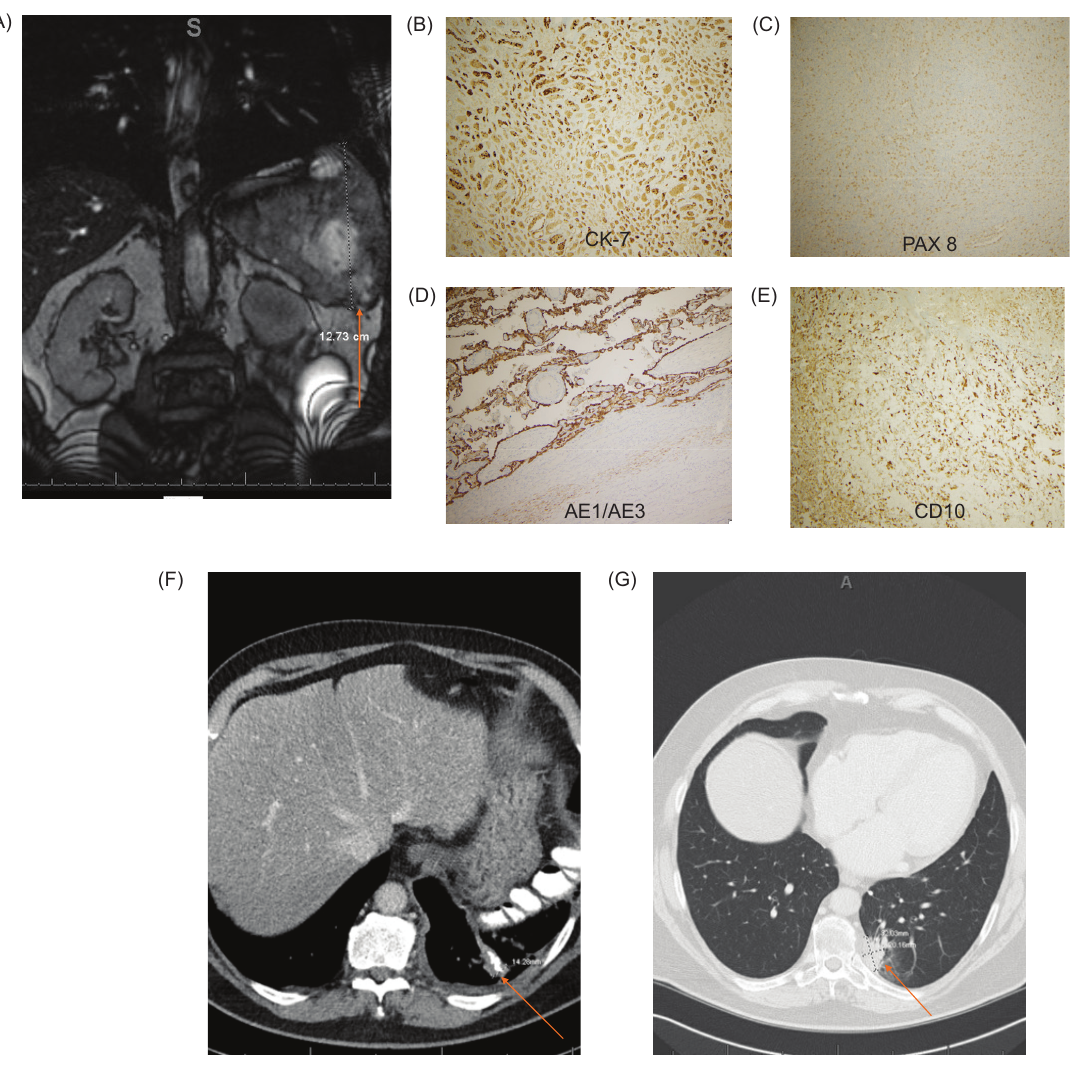
Figure 1: Radiologic and pathologic findings.